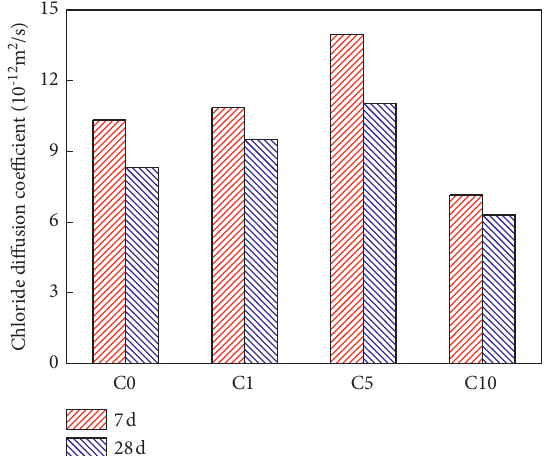
Figure 6: Chloride diffusion coefficient of CNT-mortar samples with the various dosage of CNT-COOH after 7 and 28 days of curing